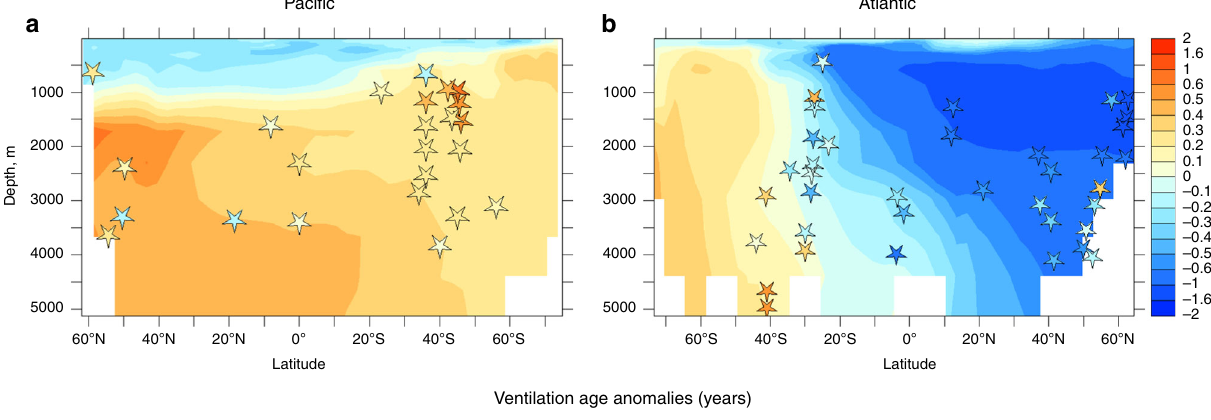
Supplementary Fig. 6 and Table 1), as ventilation of North Paci fi c